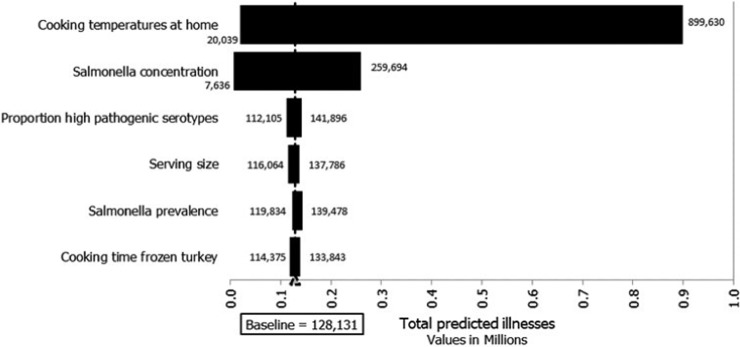
Sensitivity analysis of the influence of the model inputs on the predicted number of illnesses.